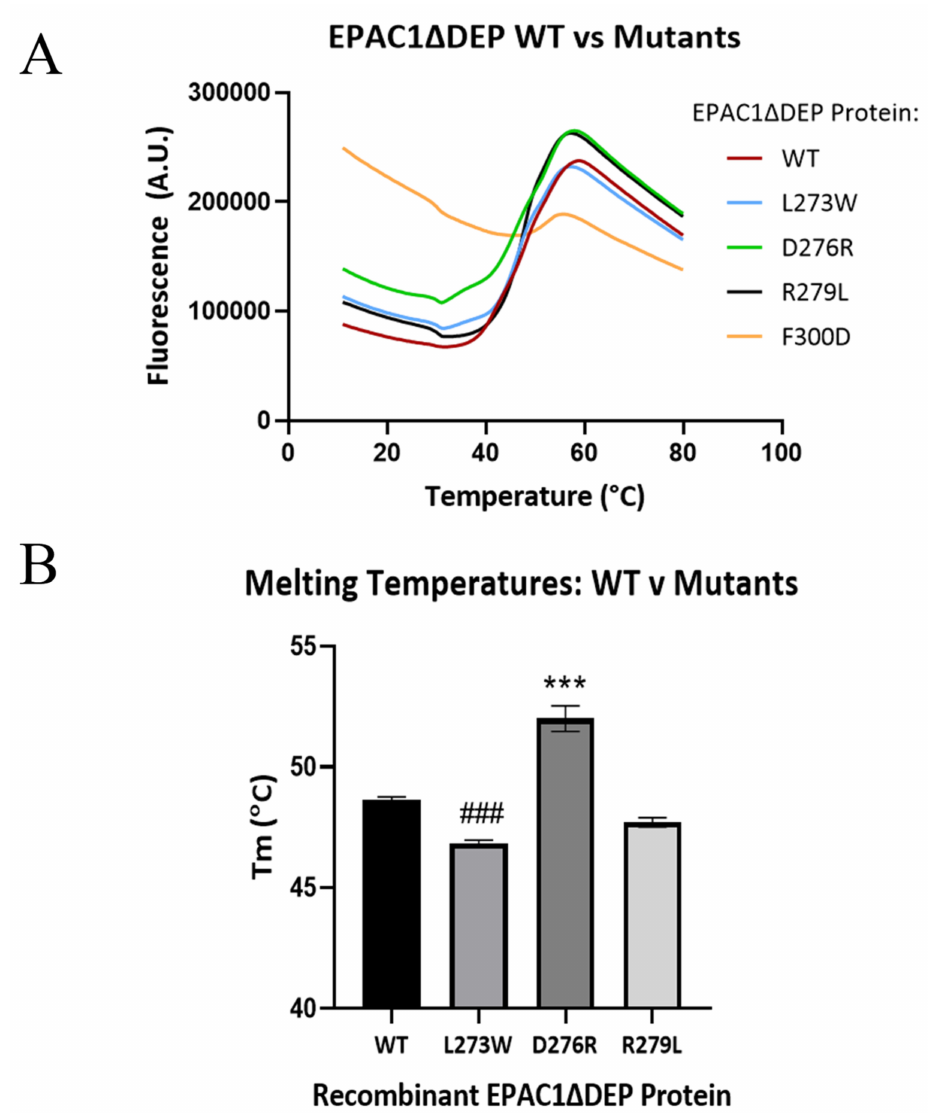
Figure 7. Thermal shift profiles of recombinant wild-type EPAC1 ∆ DEP in comparison to mutant EPAC1 ∆ DEP proteins. Thermal shift assays were performed using 1 ug of recombinant EPAC1 ∆ DEP wild-type (WT) or mutant (L273W, D276R, R279L, F300D) protein per well. Plates were incubated overnight at 4 ◦ C. with SYPRO Orange dye and then ( A ) fluorescence readouts were measured using an Applied Biosystems StepOnePlus Real-time PCR Instrument set at excitation wavelength 470 nm and emission wavelength of 570 nm over a temperature range from 11 to 80 ◦ C ramped to 0.5 ◦ C increments with plateau times of 30 s. Measurements were performed in duplicates ( n = 16–23). ( B ) Melting temperatures (Tm ± SEM ◦ C) were obtained by calculating the first derivatives of the fluorescence emission as a function of temperature ( − dF/dT). A significant decrease ( ### p < 0.0001) or increase (*** p < 0.0001) in Tm relative to WT protein was determined by one-way ANOVA (Graphpad Prism) ( n =